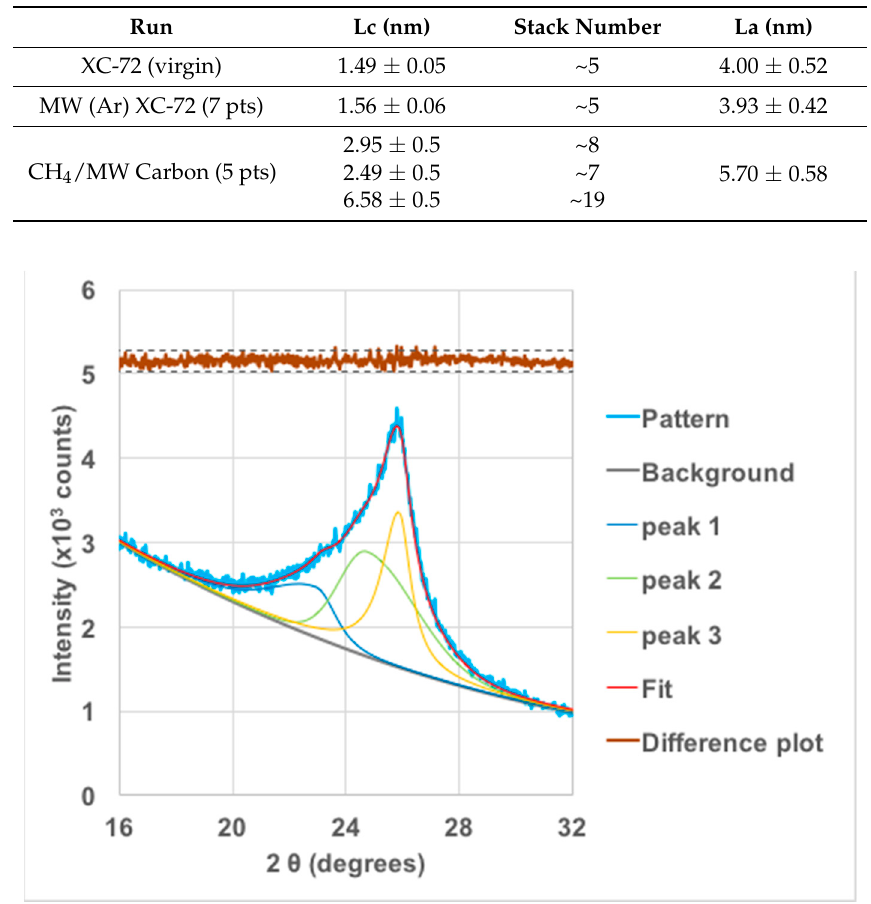
Figure 5. XRD spectrum for the MW generated carbon with a 3-peak deconvolution of the d 002 peak. Goodness of fit is shown by the residual above.